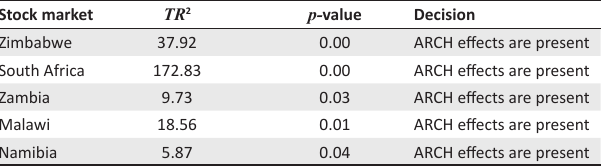
TABLE 4: Autoregressive conditional heteroscedasticity effects. Stock